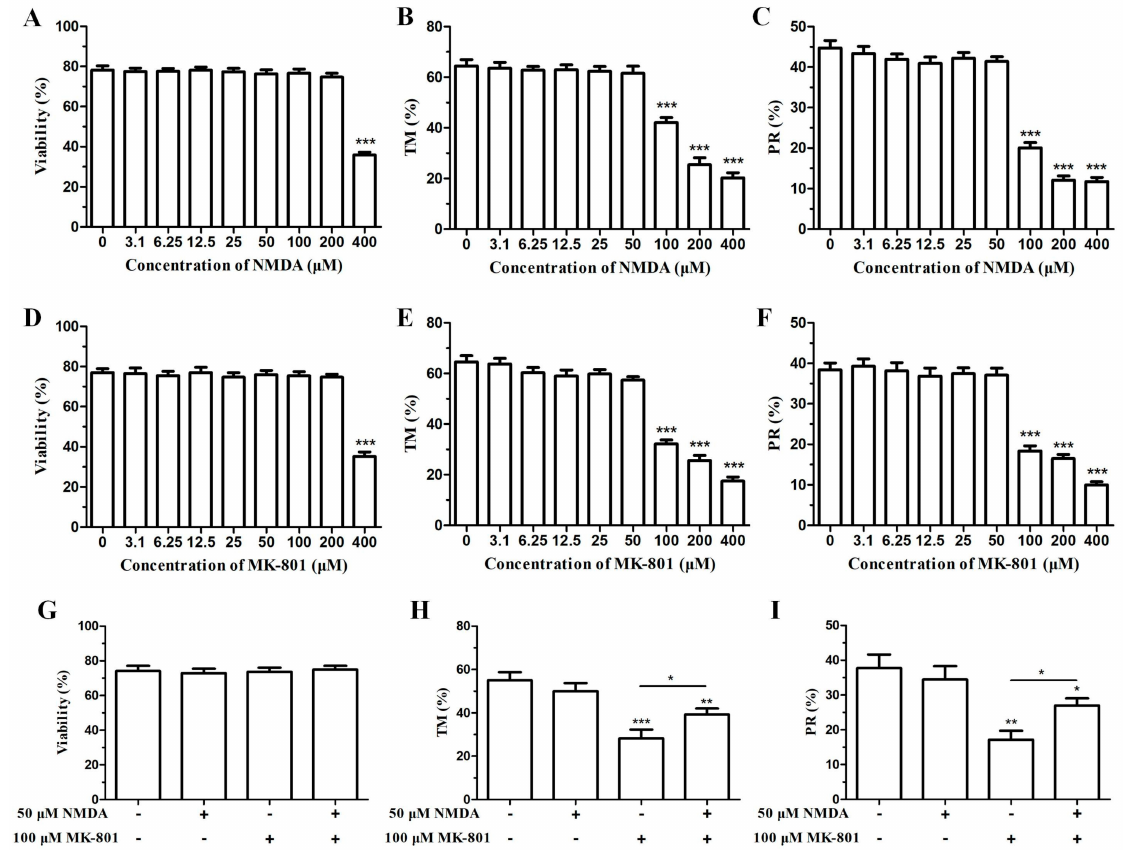
Figure 2. Effects of the NMDA receptor agonist NMDA and antagonist MK-801 on human sperm motility. Effects of different NMDA concentrations on the viability ( A ), total motility (TM, B ), and progressive motility (PR, C ) of human sperm, respectively ( n = 8). Effects of different MK-801 concentrations on the viability ( D ), total motility ( E ), and progressive motility ( F ) of human sperm ( n = 8). ( G ) Effect of the separate application or combination of 50 µ M NMDA and 100 µ M MK-801 on human sperm viability ( n = 8). ( H , I ) Effects of the separate application or combination of 50 µ M NMDA and 100 µ M MK-801 on the total motility and progressive motility of human sperm ( n = 6). Bar: mean ± SEM, one-way ANOVA; * p < 0.05, ** p < 0.01, *** p <